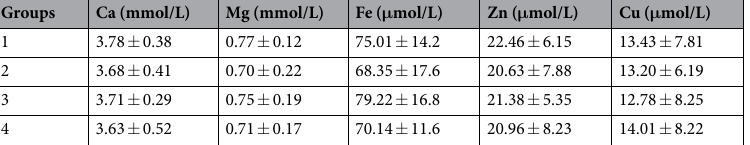
Table 2. Comparison of five physiological metal ion contents in whole blood in all four groups of mice. Data were presented as mean values ± SEM (n = 9 per